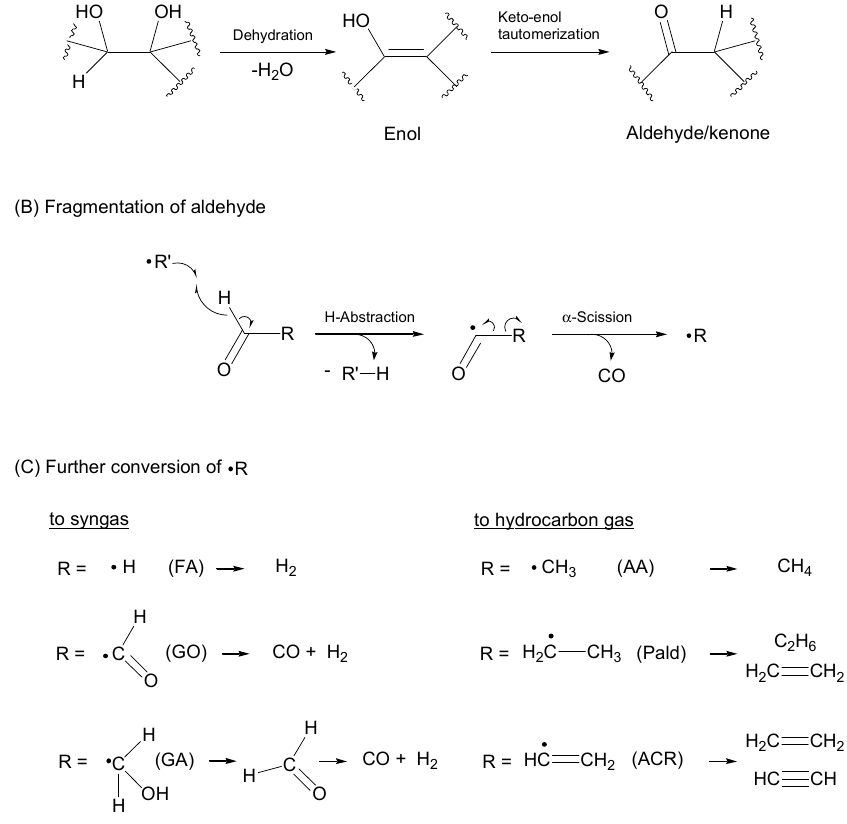
Figure 5. Gas-forming reactions considered for polyalcohols, including fragmentation of aldehyde intermediates into syngas and hydrocarbon gases.